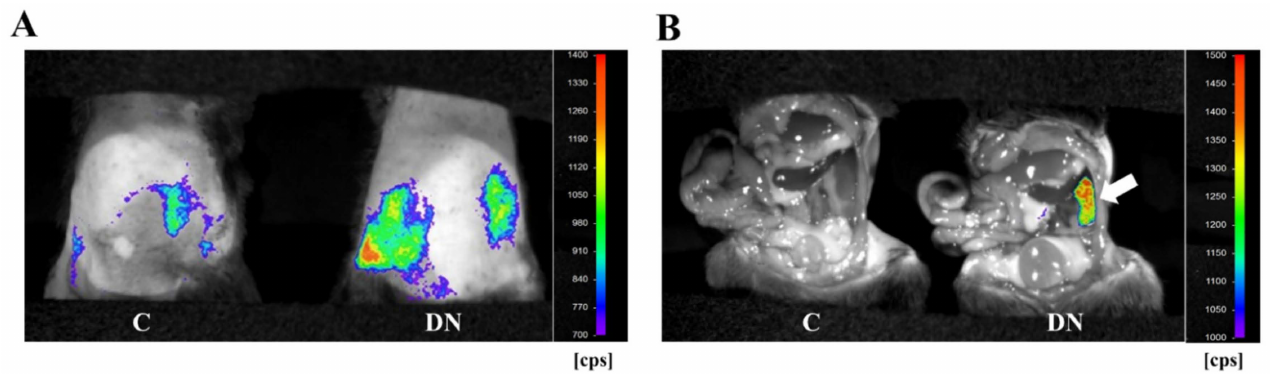
Figure 3. Visualization of renal pathology in HFD/multiple low-dose STZ-induced DN using Saa3 promoter-luc mice. ( A ) In vivo bioluminescence imaging from the back of Saa3 promoter-luc mice shows a strong intensity of bioluminescent signal (from violet for least intense to red for most intense), reflecting kidney injury. ( B ) Bioluminescent analysis of mouse organs exposed to bioluminescent imaging confirmed that the intense bioluminescent signal generated was specifically from the diabetic induced injured kidney (the white arrow), and not from the adjacent organs of the Saa3 promoter-luc mice that were induced with HFD/multiple low-dose STZ. DN = Diabetic Nephropathy, C = Control.